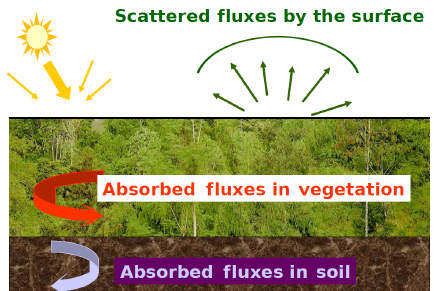
Figure 1. Schematic partitioning of the incoming solar radiation in the canopy–soil system.